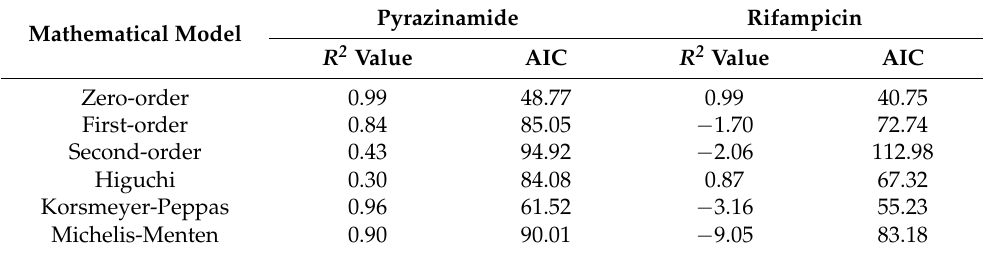
Table 6. Representative mathematical models and their respective fit parameters.